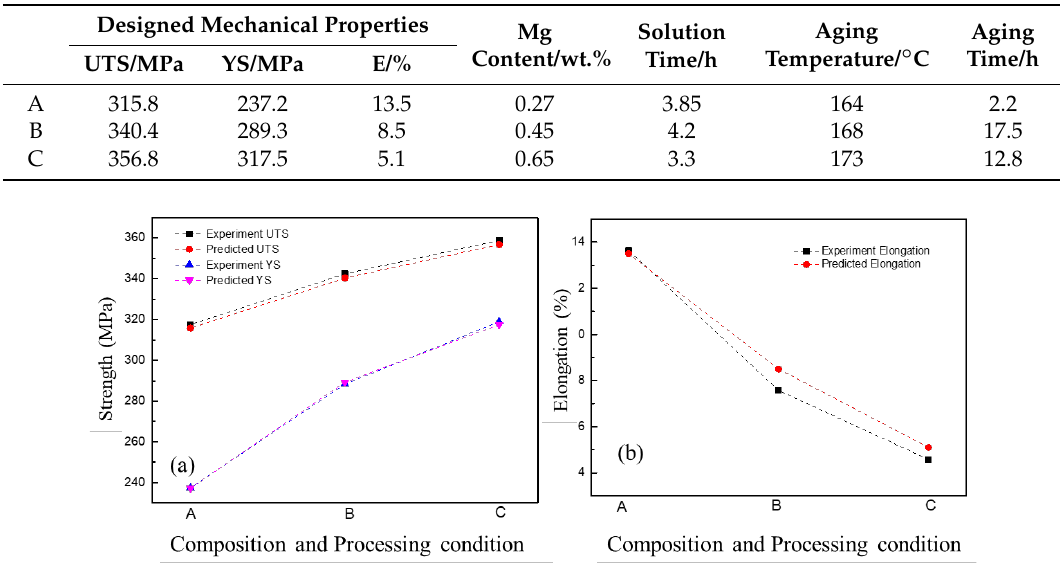
Table 7. ANN suggested optimum composition and heat treatment variables for desired mechanical properties.